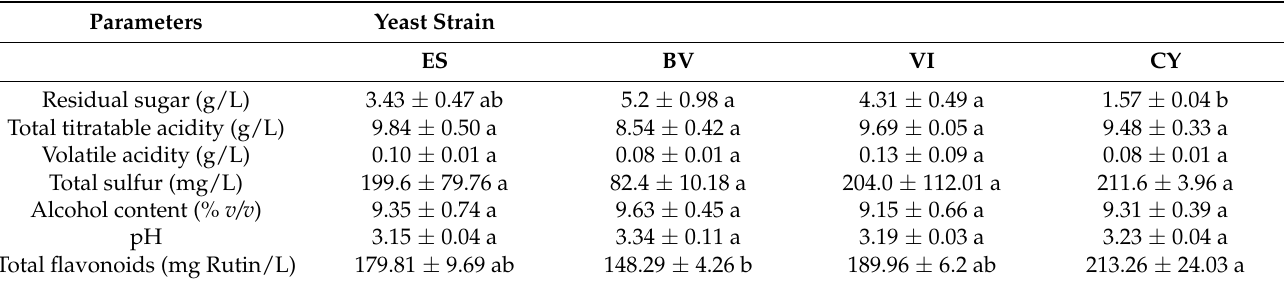
Table 1. Physicochemical indices and total flavonoids content in passion fruit wine fermented